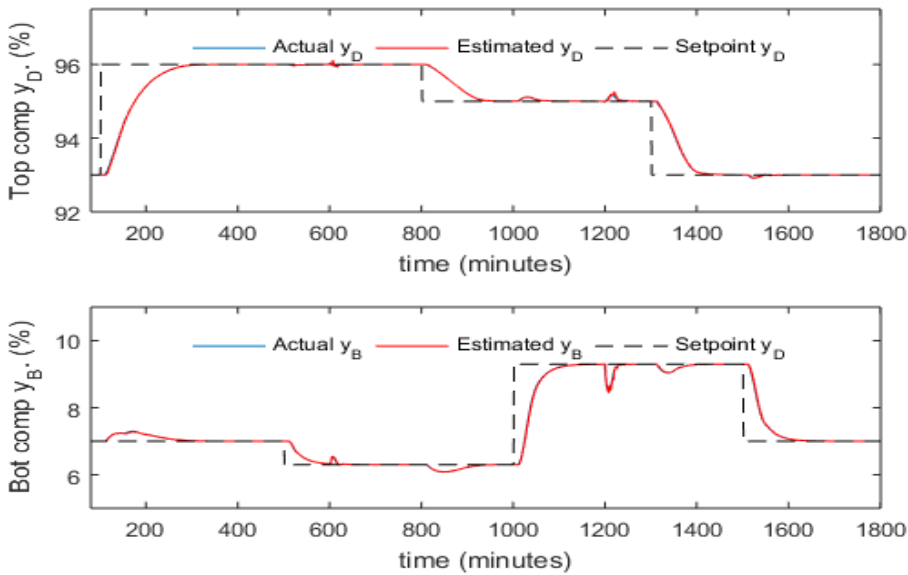
Figure 13. Responses of actual and estimated product compositions of static inferential ADRC (with mean updating).